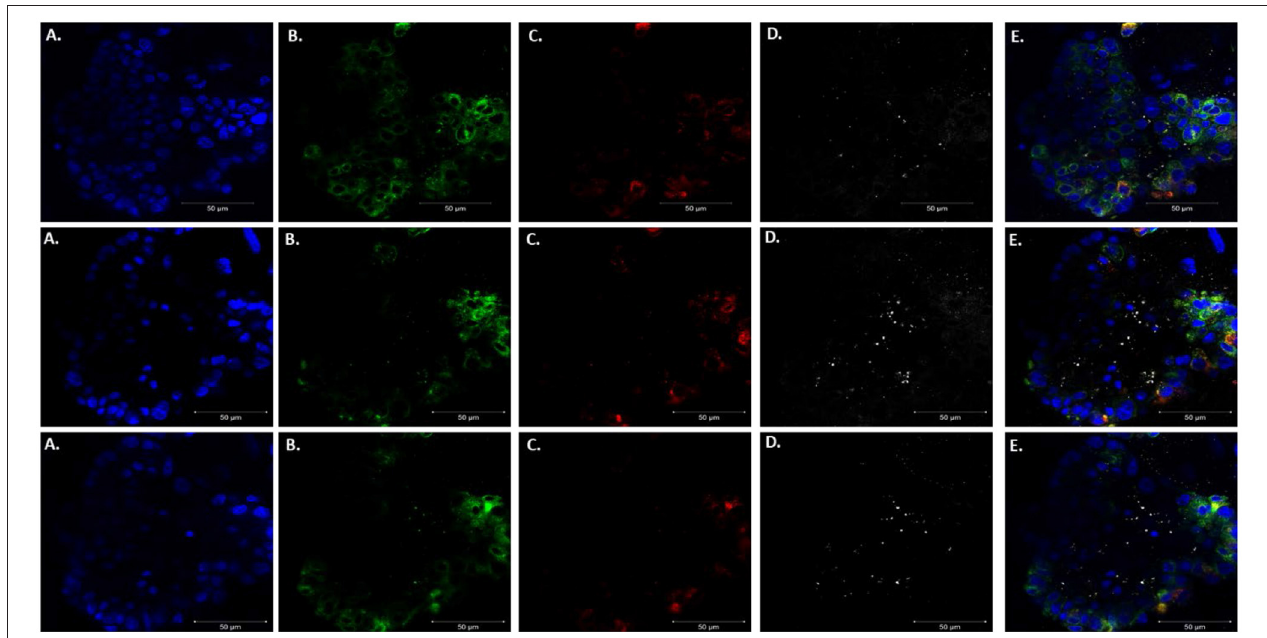
FIGURE 6 | Injecting lung organoids with P. murina . Whole lung organoid Z stack images (top, middle and bottom images) of an organoid injected with P. murina . (A) Stained with DAPI for nuclear staining (blue). (B) AQP5 AEC1 cell membrane marker (green). (C) SFTPC AEC 2 cell cytoplasmic marker (red). (D) MSG staining P. murina organisms (white). (E) Merged image of all cell markers and P. murina staining. Scale bars for the images are 50 µ